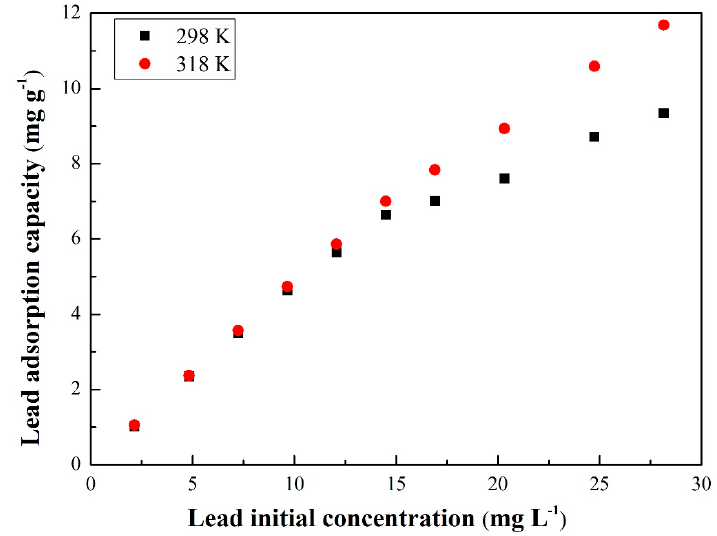
Figure 5. Adsorption isotherms of lead ions on CSHW at 298 and 318 K at a balance time of 60 min. Table 3. Parameters calculated by using the equilibrium models of lead on CSHW.